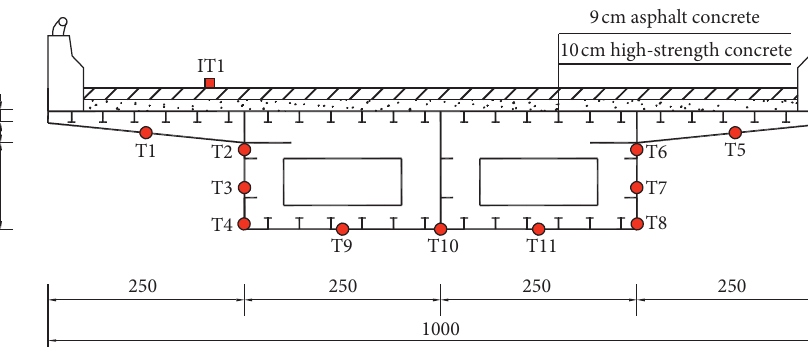
Figure 2: Layout of thermal measuring points (unit: cm).